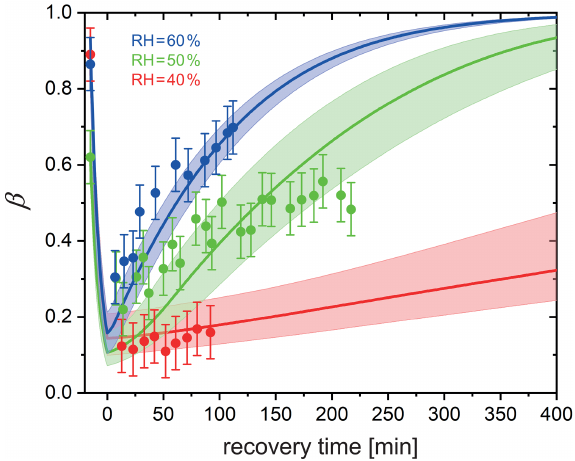
Figure 8. Reoxidation of Fe III as a function of exposure time in O 2 from STXM observations. Time before 0 represents the initial 15min irradiation procedure under He. Fe III ( Cit )/ CA (molar ratio of 1) particles at 293.5K with 40% RH (red dots), 50% RH (green dots), and 60% RH (blue dots). Lines: red (40% RH), green (50% RH), and blue (60% RH) are the Fe III fractions predicted using the PRAD model, the shaded areas indicate model output assuming ± 2% RH, ± 0 . 07 initial Fe III fraction, and ± 1 . 8% light intensity uncertainty in the STXM experimental conditions.